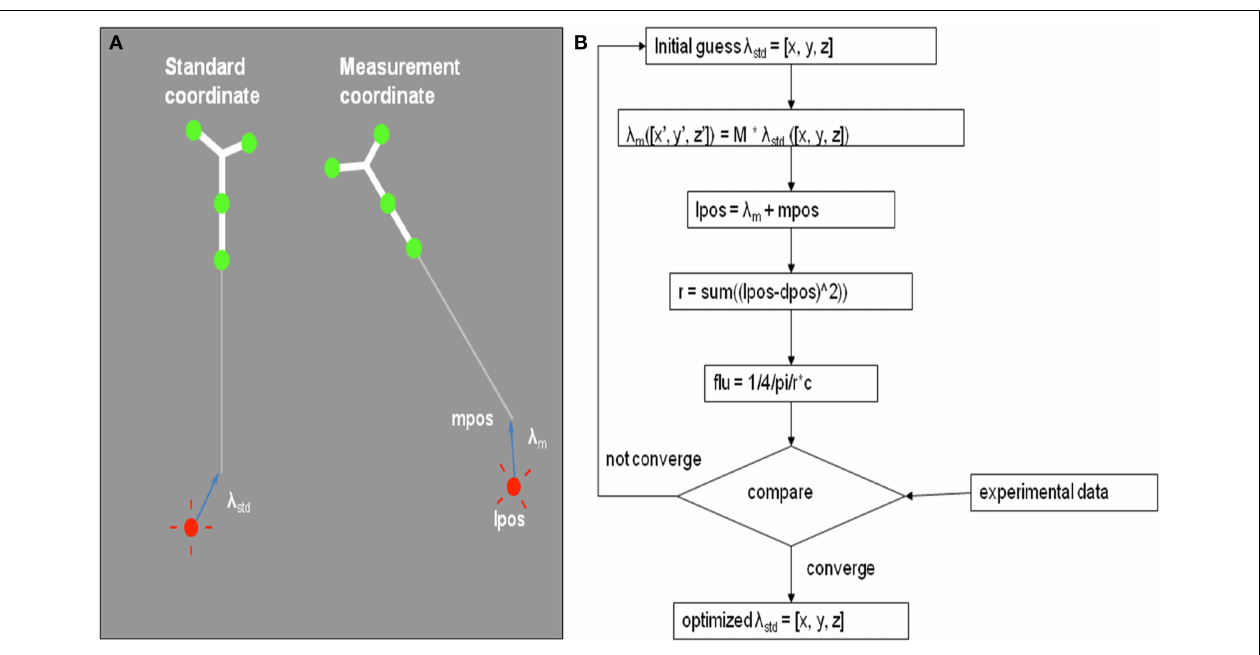
optimization algorithm to determine the shift λ m of the laser source position using 5 measurements of the treatment wand relative to an isotropic